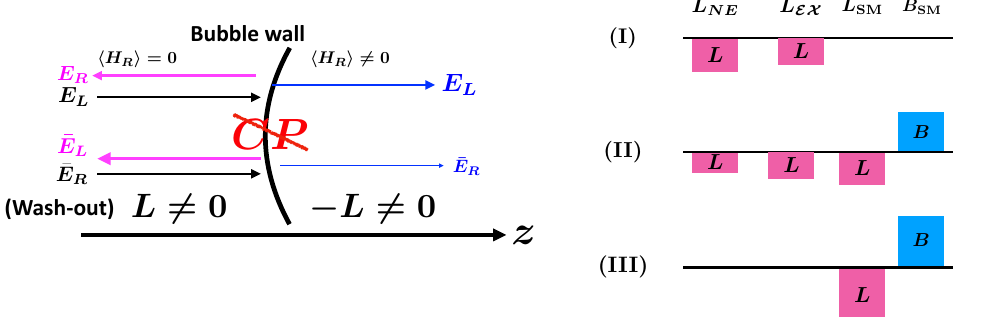
Figure 1 . An illustration of a lepton asymmetry generated by the E lepton scattering with the bubble wall is given in the left panel. Here, E and ¯ E are the left (right)-handed E lepton L ( R ) R ( L ) and its anti-particle. For instance, E L particles are injected from the symmetric phase h H R i = 0 . Some are reflected by the bubble wall while others are transmitted into the broken phase h H R i 6 = 0 . Thickness of the arrows describes the strength of reflections and transmissions. Due to the CP violation, the particles and anti-particles are reflected or transmitted differently. A nonzero lepton number in the symmetric phase is washed out. In the right panel, a schematic picture for the evolution of asymmetries is shown. L SM and B SM denote the lepton number and baryon number asymmetries carried by the SM leptons and quarks, respectively. The steps (I), (II) and (III) are explained in the main